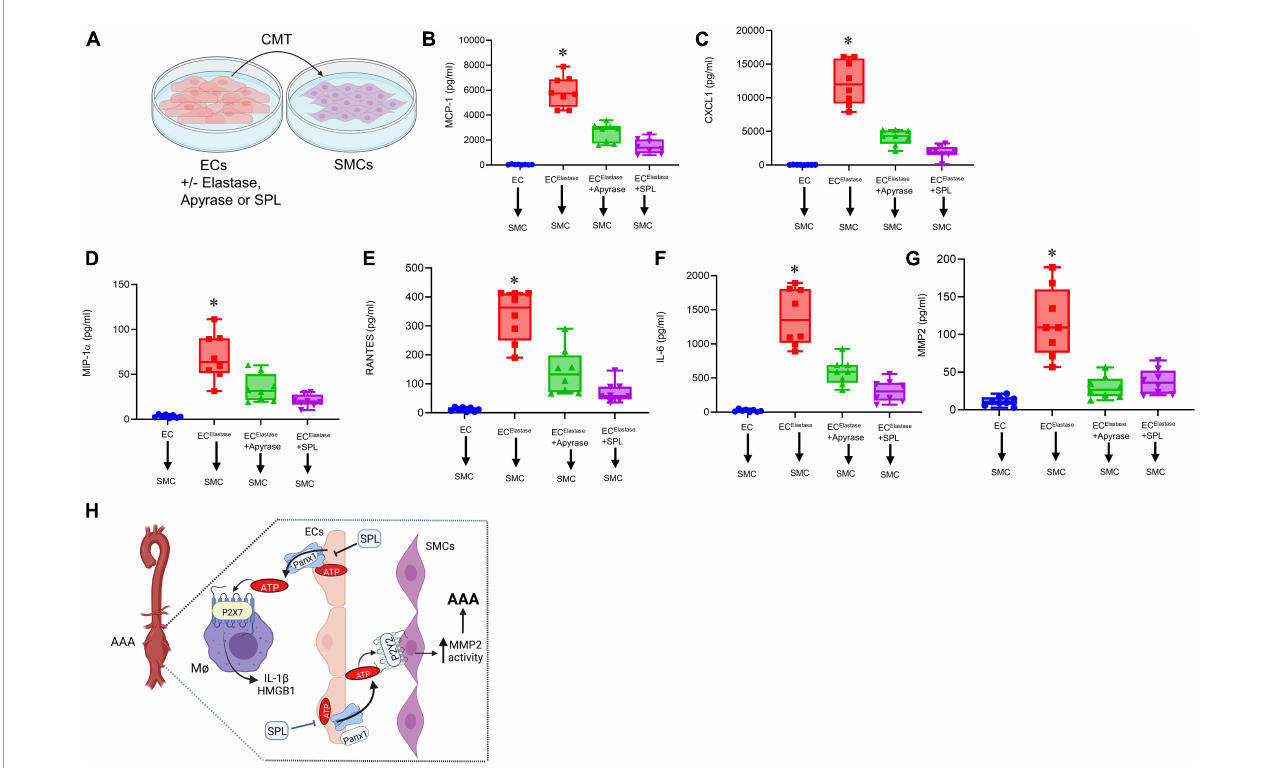
FIGURE8 Spironolactone treatment inhibits SMC activation via decreased eATP release from ECs. (A) Crosstalk of ECs with SMCs was evaluated by CMT from elastase-treated ECs to SMCs with/without pre-treatment with SPL. (B–F) Cytokine secretion was upregulated by SMCs after CMT from ECs, that was attenuated by pre-treatment of ECs with apyrase or SPL. ∗ P < 0.0001 vs. all other groups; n = 8/group. (G) MMP2 activity by SMCs was significantly attenuated by pre-treatment of ECs with SPL. ∗ P < 0.0001 vs. other groups; n = 8/group. (H) Hypothetical schematic describing the molecular signaling events during SPL-mediated protection against AAA formation. SPL treatment attenuates EC-mediated eATP release from Panx 1 channels to decrease purinergic signaling on macrophage-dependent IL-1 β and HMGB1 secretion. Also, SPL treatment mitigates eATP release from ECs to downregulate SMC-dependent pro-inflammatory cytokine secretion and MMP2 activity. Collectively, SPL-treatment attenuates vascular inflammation and remodeling to inhibit the progression of AAA formation. ECs, endothelial cells; SMCs, smooth muscle cells; HMGB1, high mobility group box 1; M (cid:56) , macrophages; SPL,